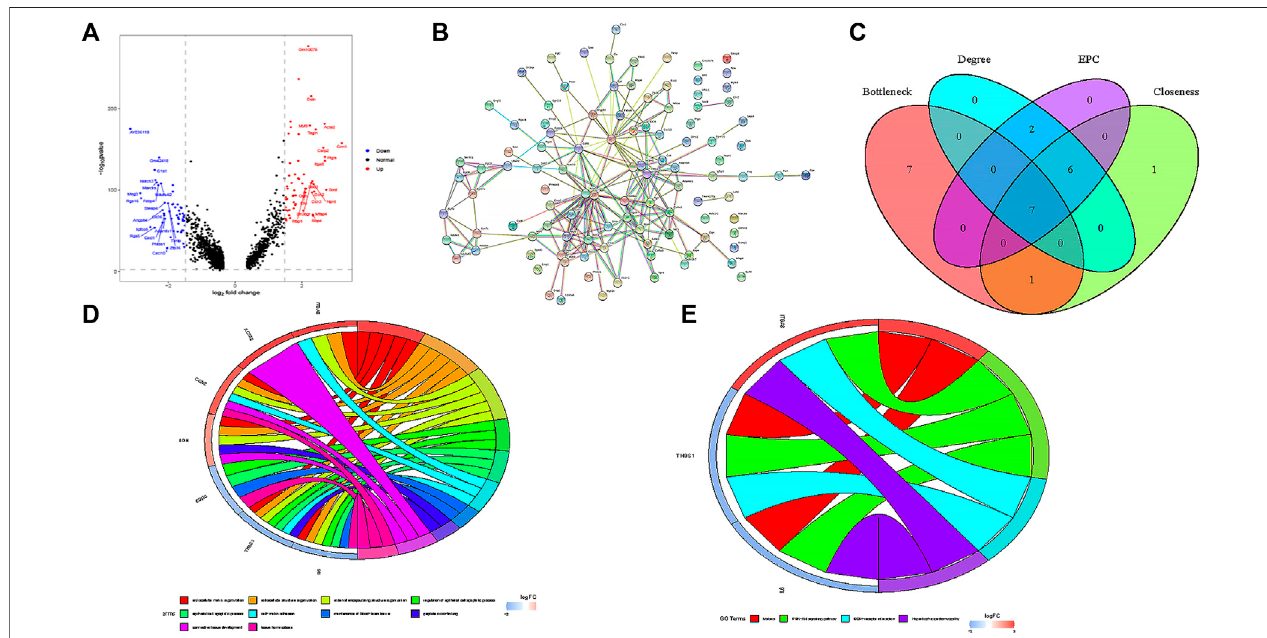
FIGURE 4 | Functional analysis of smooth muscle cells. (A) Volcanic map of DEGs in smooth muscle cells. (B) PPI network of DEGs. (C) seven hub genes were identi fi ed by overlapping the fi rst 15 genes in the four classi fi cation methods of cytoHubba. (D) GO enrichment analysis of seven hub genes. (E) KEGG enrichment analysis of seven hub genes.